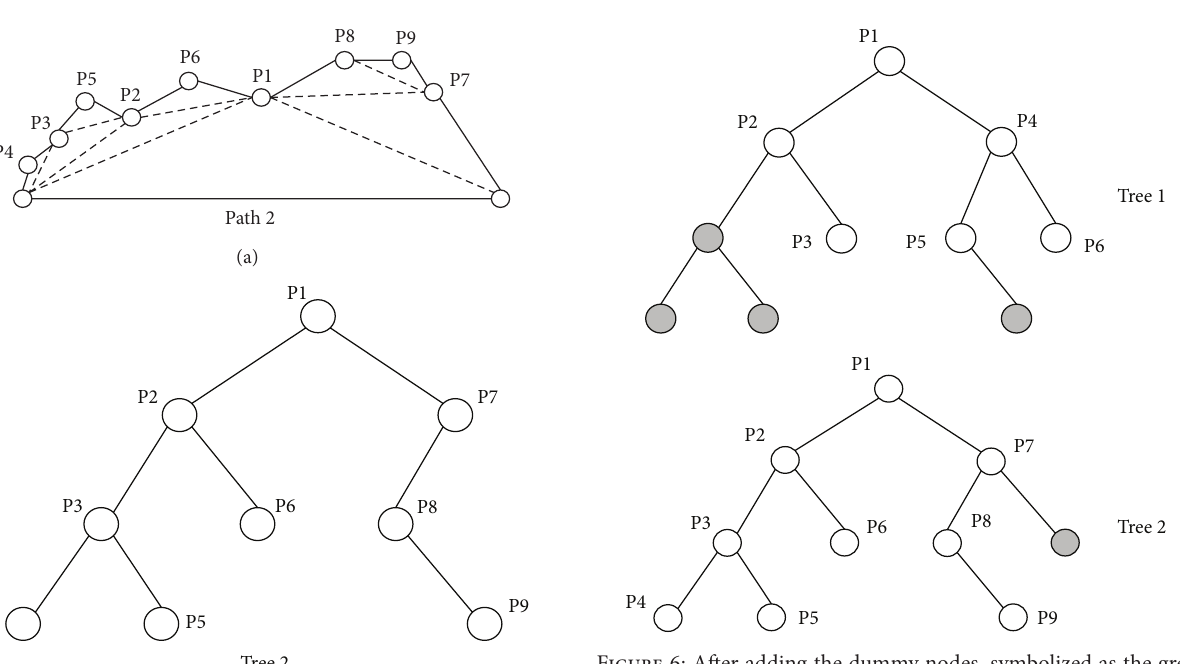
Figure 6: After adding the dummy nodes, symbolized as the grey circles, the two different binary trees have the same attitude.